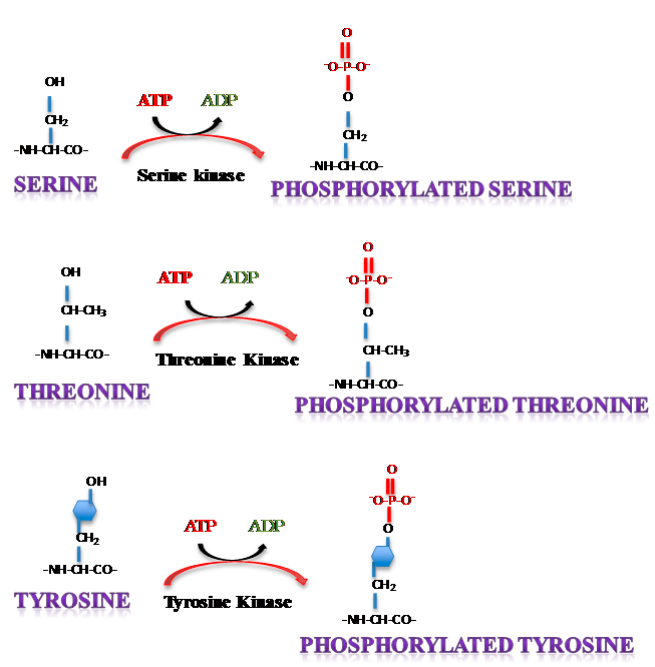
Figure 1. Post translational addition of a phosphorylation moiety on Serine, Threonine or Tyrosine residues. ATP: Adenosine triphosphate, ADP: Adenosine diphosphate.